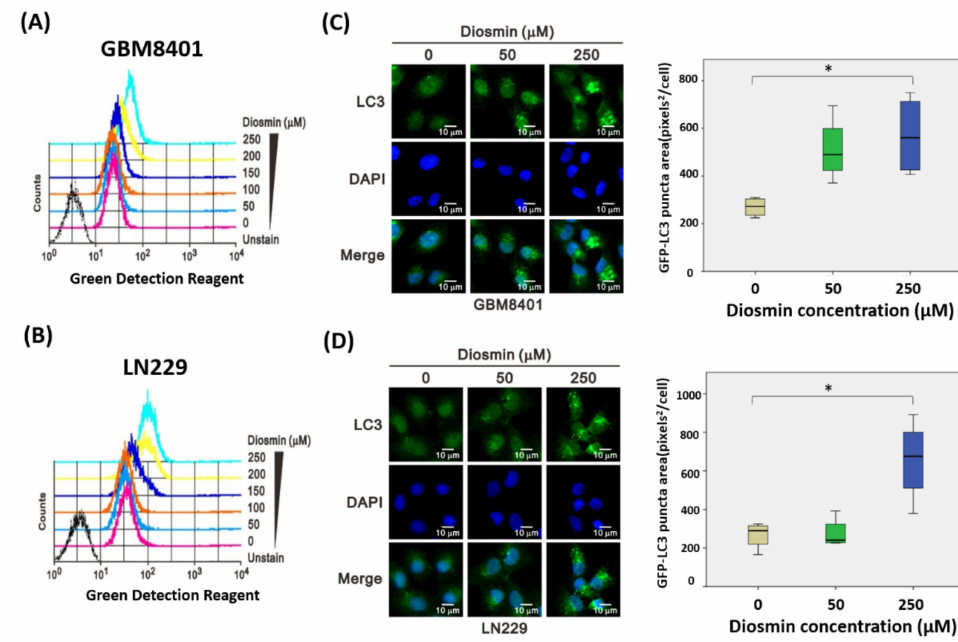
Figure 7. Diosmin induces LC3-II expression in GBM cells. ( A , B ) Flow cytometric analysis of the number of autophagic vacuoles in GBM8401 and LN229 cells exposed to increasing concentrations of diosmin for 48 h. ( C , D ) Left: LC3-II immunofluorescence imaged after incubation of GBM8401 ( C ) and LN229 ( D ) cells for 48 h with the indicated concentrations of diosmin. Representative images used for thresholding quantification are shown. Right: Box plots showing the total areas of the green fluorescent puncta within the cells (mean ± SEM of 4 independent experiments; * p < 0.05, Student’s t